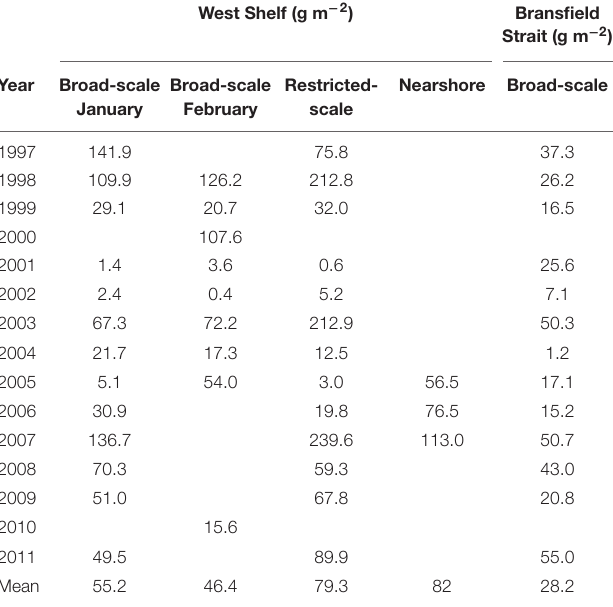
TABLE 3 | Previous estimates of the mean biomass density (g m − 2 , rounded to the nearest decimal point) of krill over the West Shelf and in the Bransfield Strait developed from ship-based acoustic surveys conducted by the U.S. AMLR